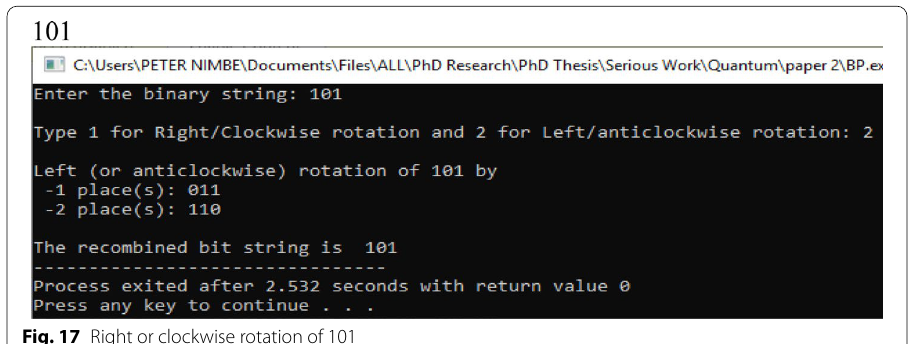
Fig. 17 Right or clockwise rotation of 101